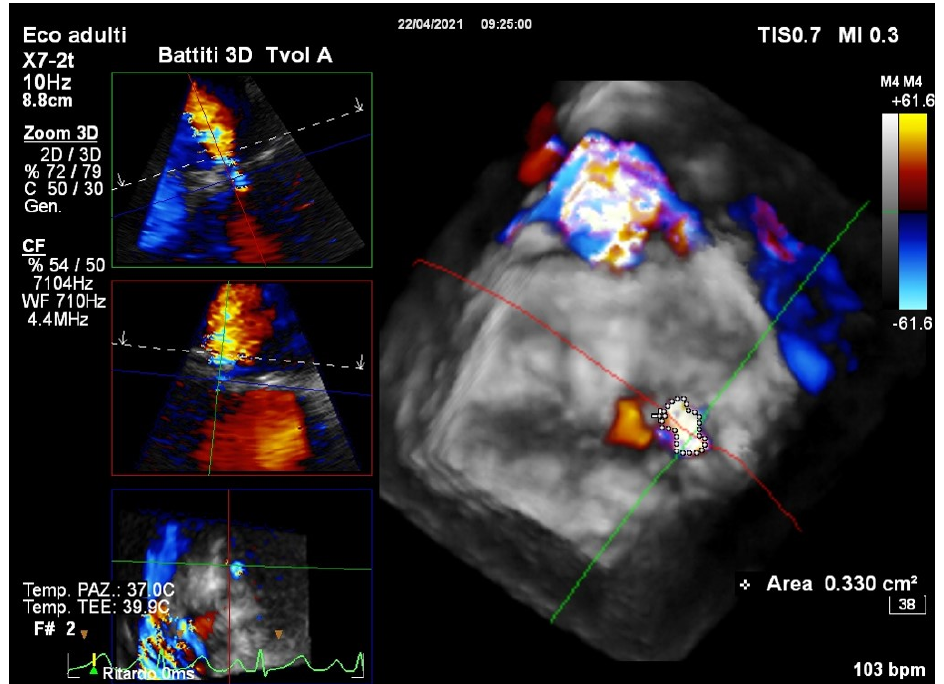
Figure 2. A RT3D color Doppler TEE dataset in a patient with severe AS and functional MR. The display of a 3D analysis software (Philips Medical Systems) showing a 3D view of the mitral valve and the MR jet from an LA perspective (right) and three reconstructed image planes in an orthogonal orientation of the MR jet: long-axis LVOT view (top left), 2-chamber view (middle left), short-axis view (bottom left) showing the asymmetric VCA (0.33 cm 2 by direct planimetry). Since the formula assumes a relatively round orifice, the PISA by 2D echocardiography tends to underestimate secondary MR. EROA is often highly variable, even when holosystolic, so peak EROA (single frame showing the largest proximal flow convergence zone) can overestimate MR. Several recent studies compared 3D VCA measurements to other methods, especially for the quantification of MR, and found that the more asymmetric the VCA was, the better the accuracy of 3D measurements compared to 2D measurements. However, because of color Doppler blooming effects, the inclusion of low-velocity signals in the tracing, and the orifice’s nonplanarity, 3D VCA can overestimate EROA. Therefore, further clinical research is needed to determine new 3D VCA cutoff values. RT3D: real-time three-dimensional echocardiography; TEE: transesophageal echocardiography; MR: mitral regurgitation; AS: aortic stenosis; LA: left atrial; LVOT: left ventricular outflow tract; VCA: vena contracta area; PISA: proximal isovelocity surface area; 2D: bi-dimensional echocardiography; EROA: effective regurgitant orifice area.